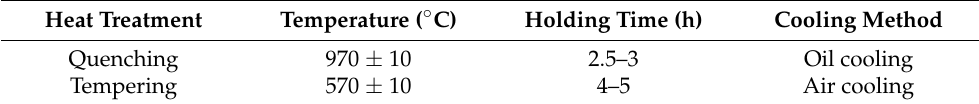
Table 3. Heat treatment